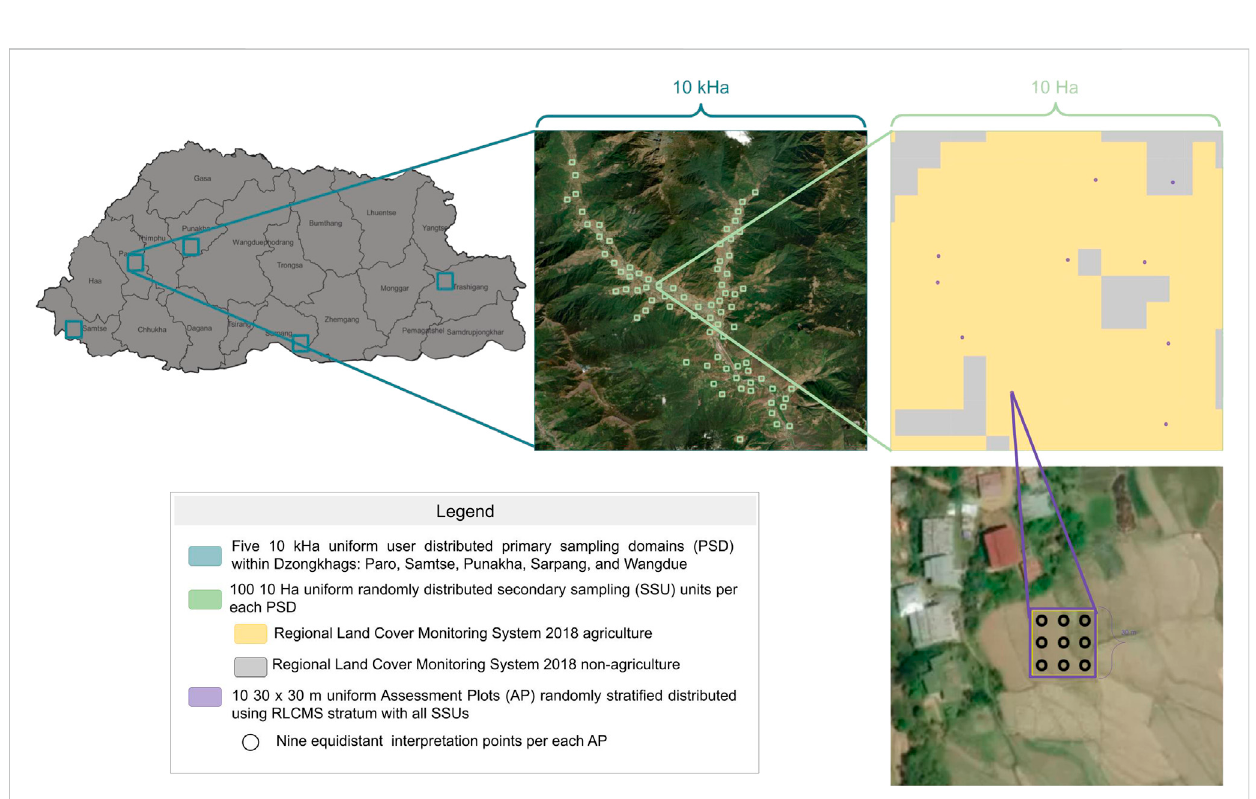
FIGURE 3 Training Sample Design leveraging Google Earth Engine, Collect Earth Online, and SERVIR ’ s Regional Land Cover Monitoring System.